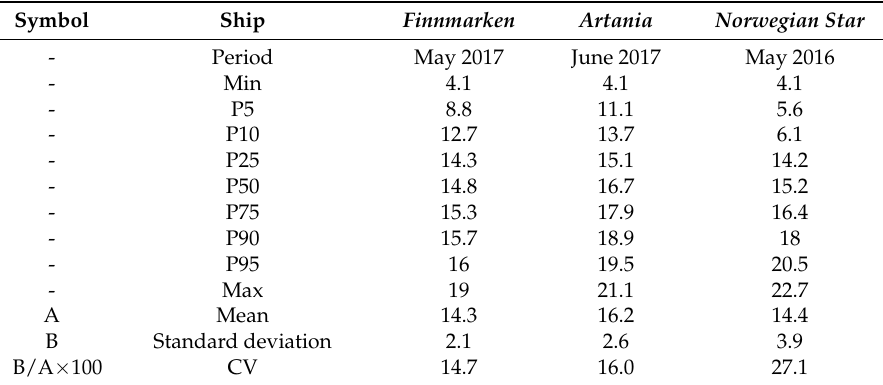
Table 8. Percentiles and descriptive statistics for speed distributions.